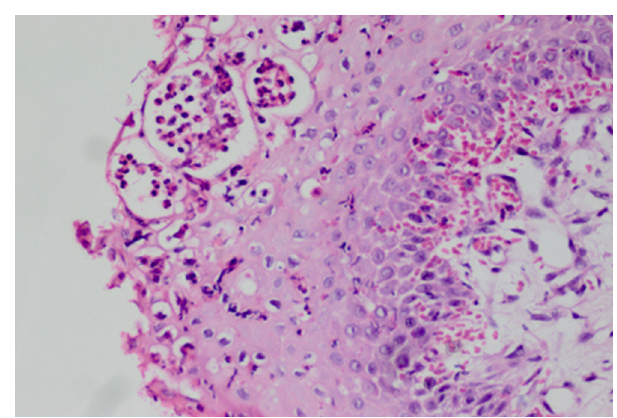
Acute inflammation confined to the mucosa (H---E 400 × ). extending the submucosa in two animals (Fig. 4). Increased inflammation was seen in the group C compared to group B.